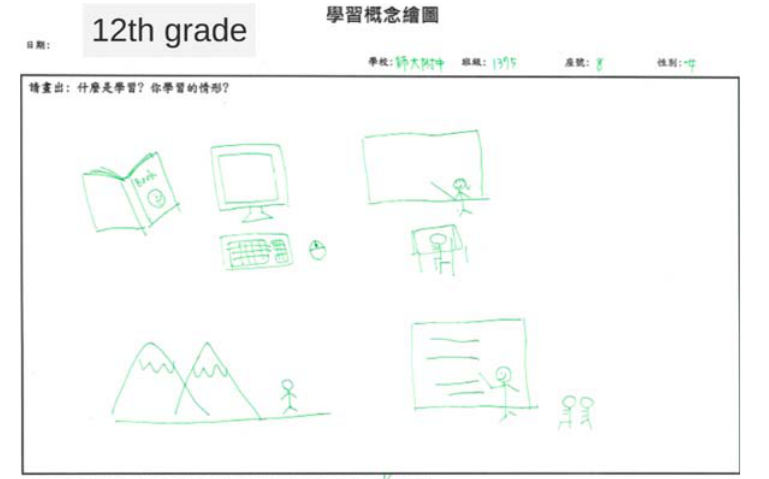
Figure 7. A drawing by a 12th